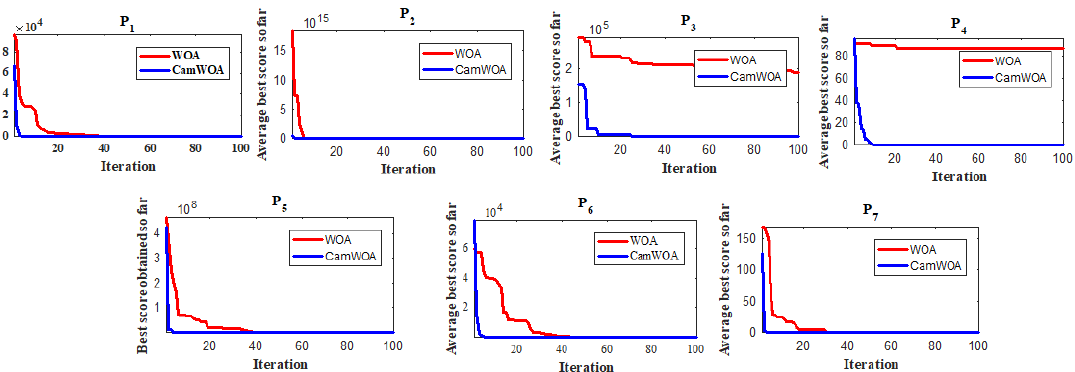
8 , p 9 , p 10 , p 11 , p 12 , p 13